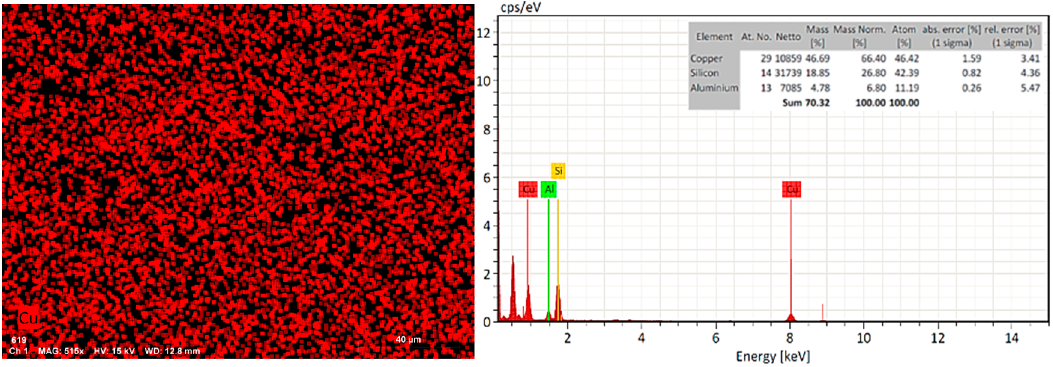
Figure 3. SEM-EDX. EDX analysis to nZ after acid treatment (nZH sample).